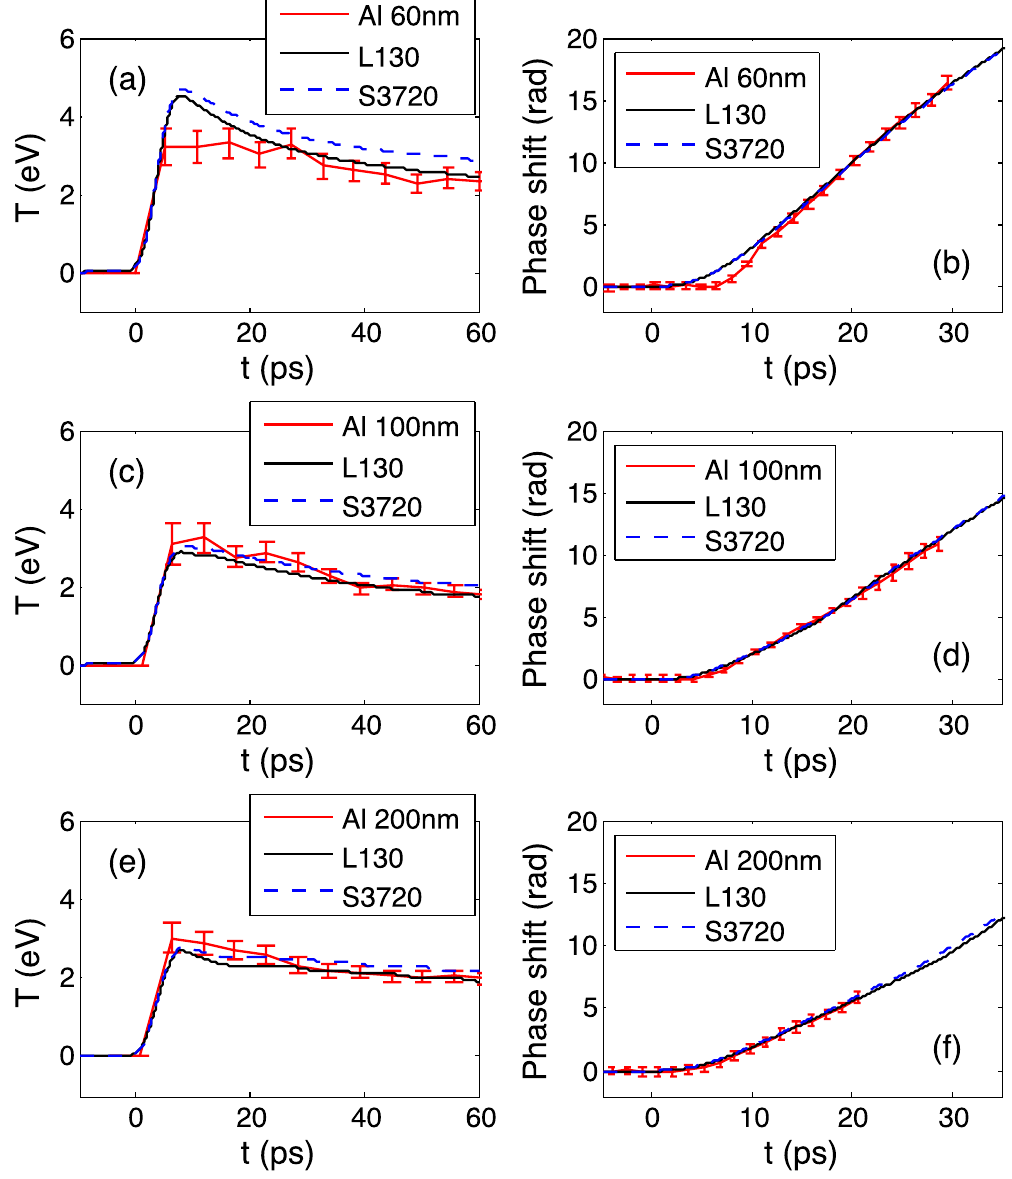
Figure 3. Comparison of 100 nm Au + 60 nm ( a ) /100 nm ( c ) /200 nm ( e ) Al SOP data with HYDRA simulations using LEOS L130 and Sesame 3720 for Al EOS, and Purgatorio for the thermal conductivity. ( b , d , f ) are corresponding comparisons with the FDI